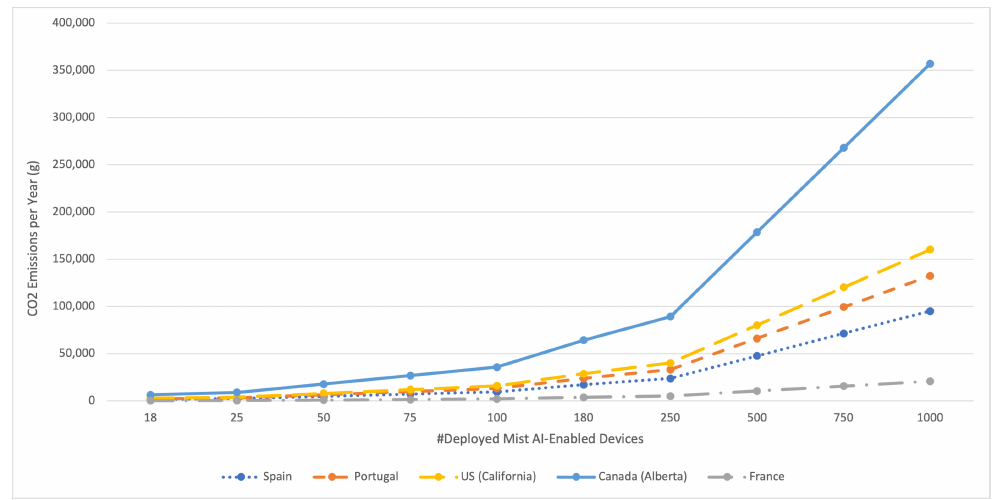
Figure 12. Estimated CO 2 emissions for different number of deployed devices for different countries.